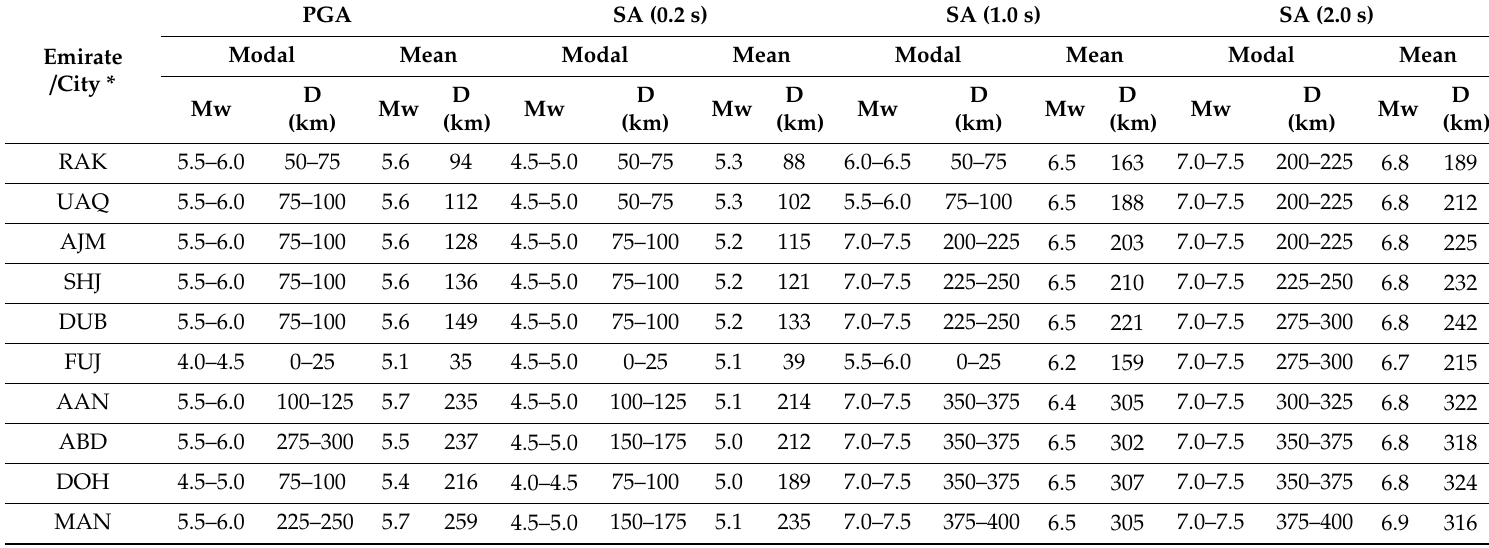
Table 6. Mean and modal seismic hazard deaggregation results (for magnitude and distance) for a return period of 475 years, for the studied emirates and cities, and for the di ff erent spectral periods [PGA, SA (0.2 s), SA (1.0 s), and SA (2.0